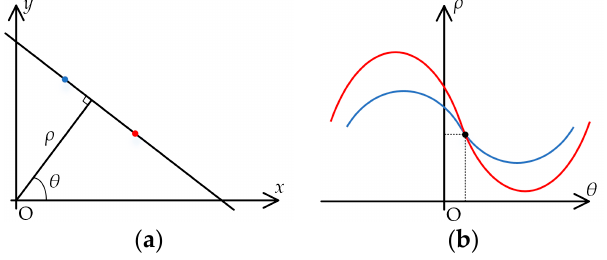
Figure 2. Dual relationship between xy -space and ρθ -space. ( a ) xy -space; ( b ) ρθ -space.